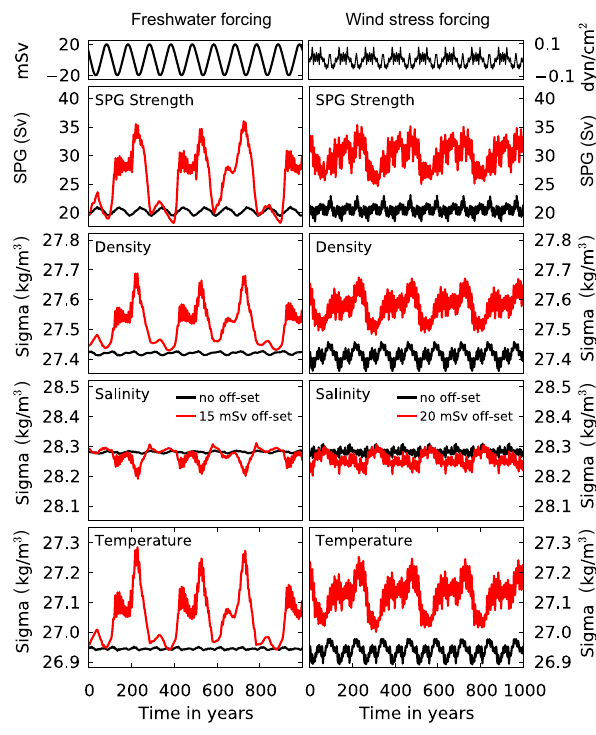
Fig. 4. Time series of SPG strength showing enhanced variabil- ity near the dynamical threshold due to the baroclinic feedback. Left panels show the response to sinusoidal freshwater forcing with 20mSv amplitude and a period of 100yr, right panels to NCEP- NCAR surface wind stress anomaly. Red curves are with constant freshwater off-set of 20mSv and black curves are without off-set. Narrow upper two panels show the time-varying forcing. The large panels show from top to bottom SPG strength, density variations, density variations due to salinity alone and density variations due to temperature alone. Averages are taken between 37.5 ◦ W–18.75 ◦ W and 45 ◦ N–60 ◦ N in the upper 1000m. In both the cases of fresh- water and wind forcing the SPG variability is significantly weaker than observed when the system is far from the threshold (black curves). In the vicinity of the dynamical threshold of Fig. 1, the SPG variability is drastically increased. The main density signal is produced by temperature variations. Major salinity changes are re- stricted to the surface layers, but play a key role in the process of self-amplification (see Fig.